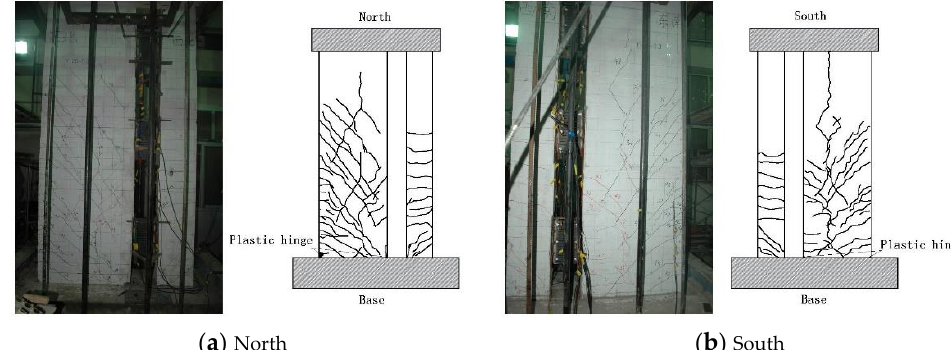
Figure 7. Failure model of specimen R-0.3.